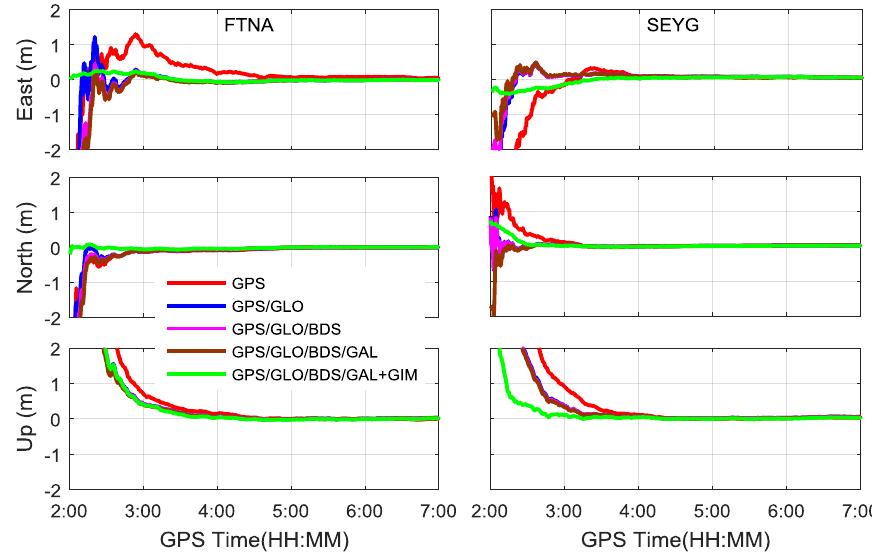
Figure 4. Single-frequency PPP errors for different processing scenarios using datasets at FTNA and